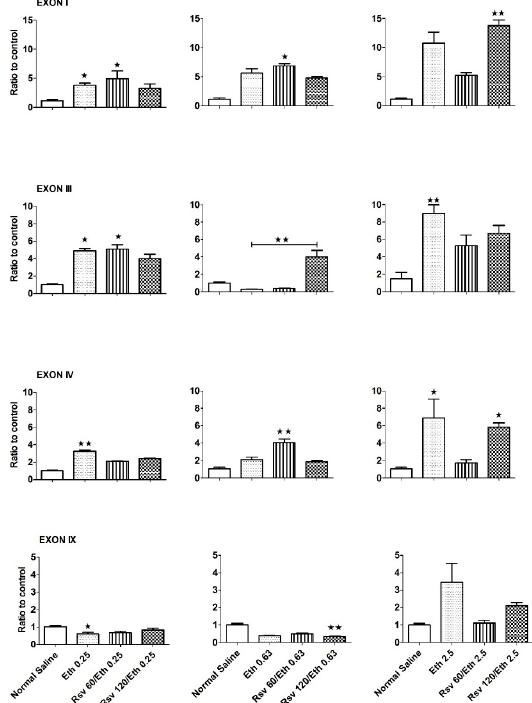
Figure 2. Differential effects of Eth and Rsv on the expression of BDNF exons in the hippocampus of embryonic rats. Eth (0.25 g/kg·BW/day) significantly increased expression of BDNF exons I, III and